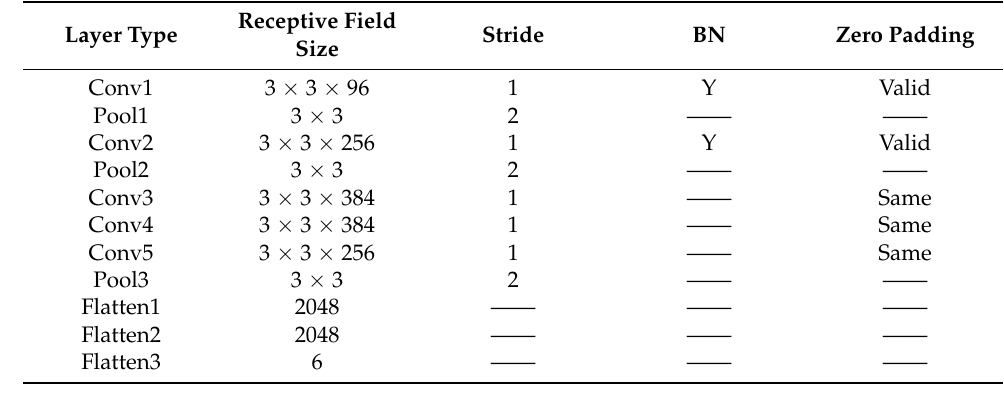
Table 3. Adap–Alex structure parameter setting.